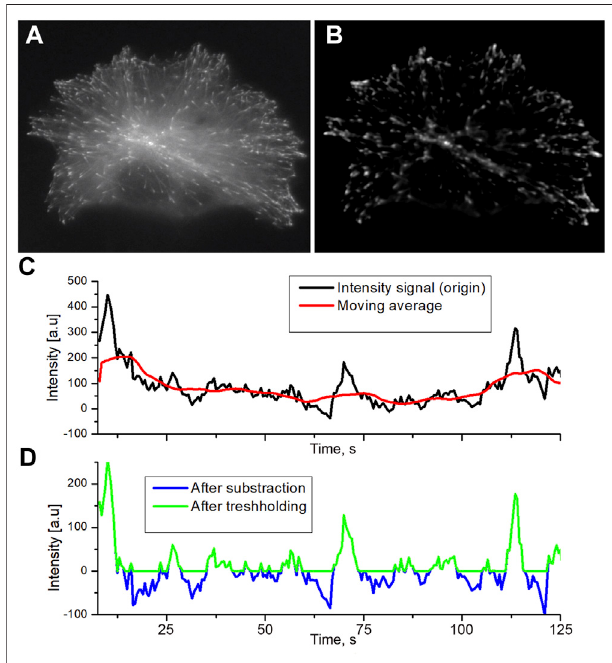
FIGURE 1 | Raw initial image of EB comets in the transfected HT-1080 cell (A) and normalized image by the running averaging and thresholding applied (B) . The background in the normalized image is set to 0 intensity. Original pro fi les and moving average fi ltering (C) black line: original intensity, red line: the result of moving average. The thresholding of intensity aftersubtractionofthemovingaverage (D) ismarkedbyablueline.Greenline: intensity after thresholding. All negative values were assigned to